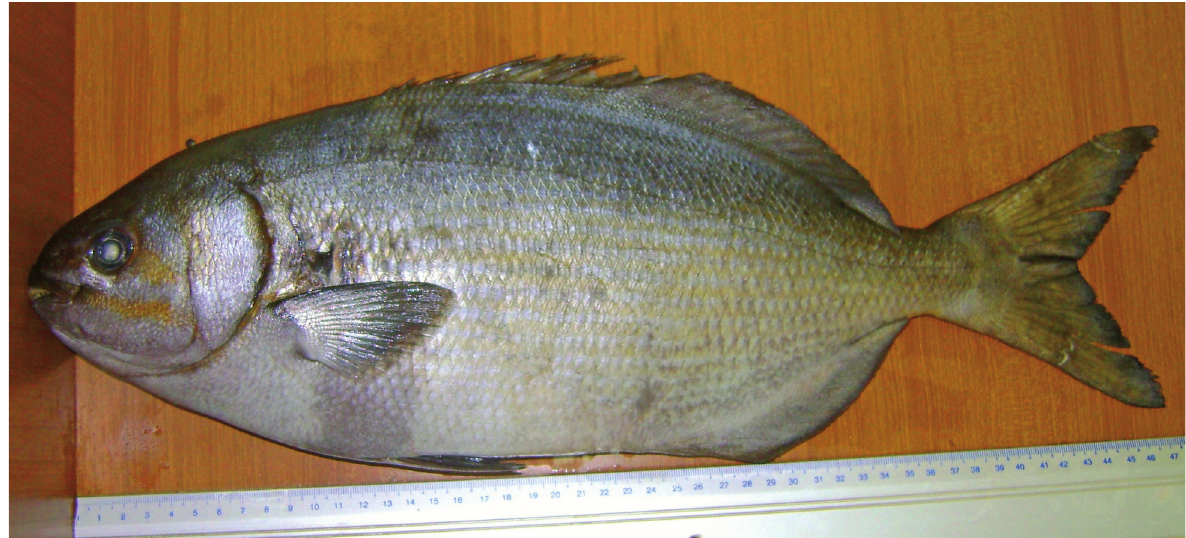
Fig. 1. Specimen of Kyphosus saltatrix captured in Libyan